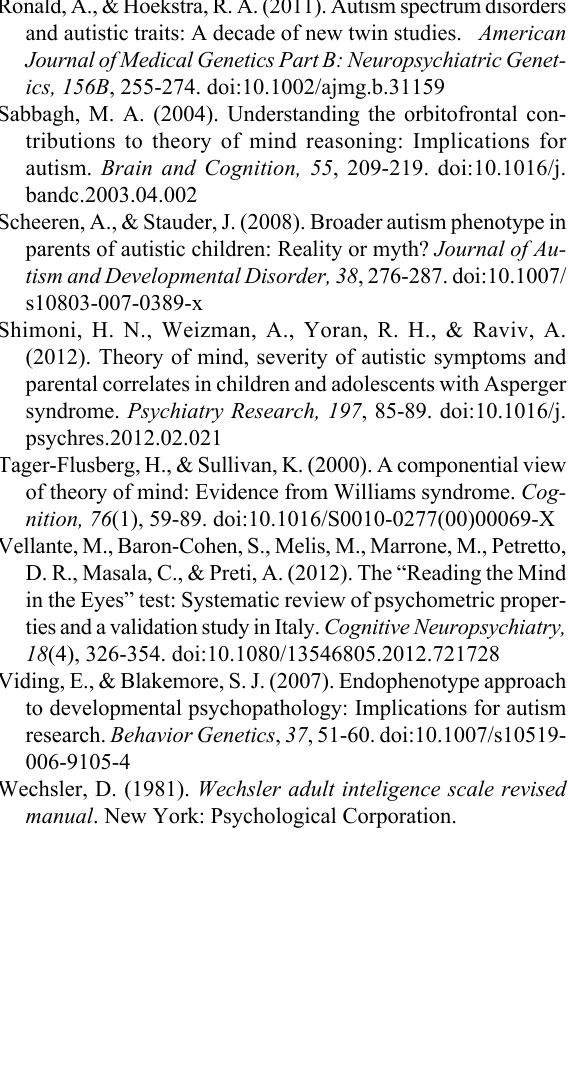
manual . New York: Psychological